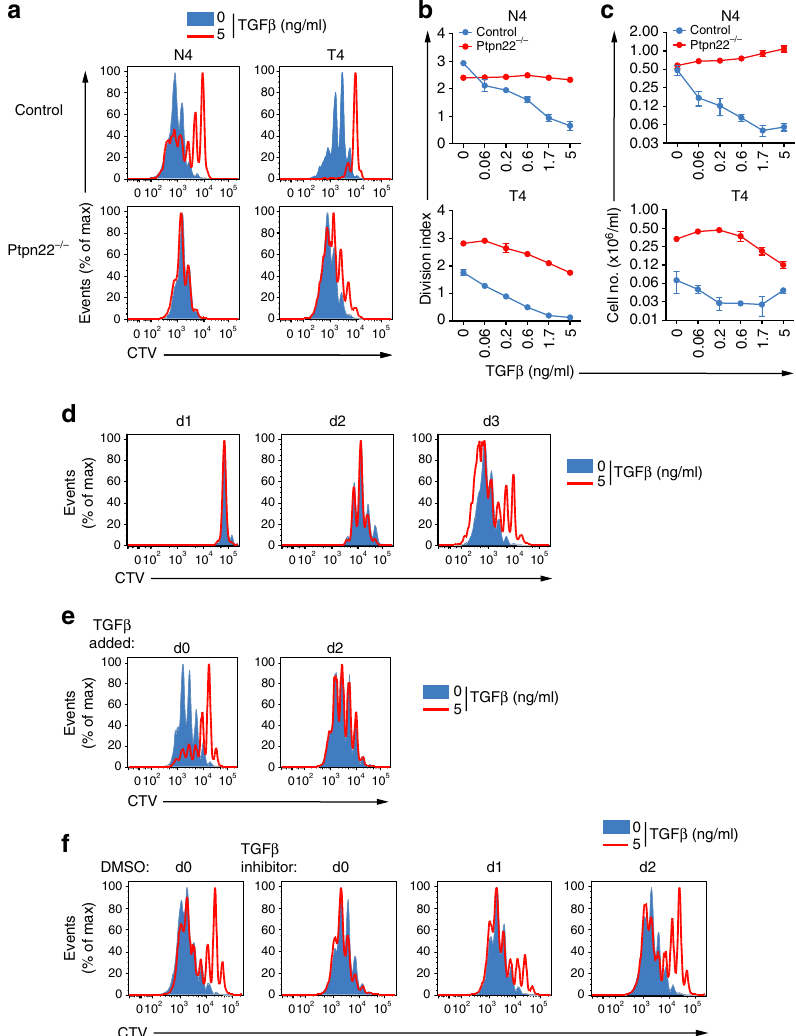
Fig. 1 Ptpn22 de fi ciency protects cells from TGF β -mediated suppression. a Dilution of Cell Trace Violet (CTV) in control and Ptpn22 − / − OT-1 cells was used to assess proliferation of cells stimulated with N4 or T4 peptide (10 − 6 M) for 3 days in the presence of varying doses of TGF β (0 – 5 ng/ml). b Proliferation was quanti fi ed by calculation of division index (FlowJo). c Numbers of live control and Ptpn22 − / − OT-1 cells recovered after stimulation was calculated using MACSquant software (mean ± s.d. for triplicate replicates). d TGF β inhibition becomes apparent only after 2d of culture. Dilution of CTV from control OT-1 cells stimulated with T4 (10 − 6 M) ± TGF β (5 ng/ml) after d1, d2, or d3 of culture. e Dilution of CTV violet from control OT-1 cells stimulated with T4 (10 − 6 M) ± TGF β (5 ng/ml) added at d0 or d2 of culture. f Inhibition of TGF β R1 signaling, by addition of ALK-5/TGF β R1 inhibitor SB431542, at d0 interferes with TGF β -mediated suppression of proliferation, but SB431542 is less effective when added on d1 or d2 of culture. Control OT-1 cells stimulated with T4 (10 − 6 M) ± TGF β (5 ng/ml) were cultured for 3d ± 5 μ M SB431542 (or DMSO vehicle control) added on d0, d1, or d2 of culture. Representative histograms of CTV dilution analysed by fl ow cytometry are shown in a , d , e , f . Data are representative of 5 ( a – c ), 2 ( d , e ), and 3 ( f ) separate experiments